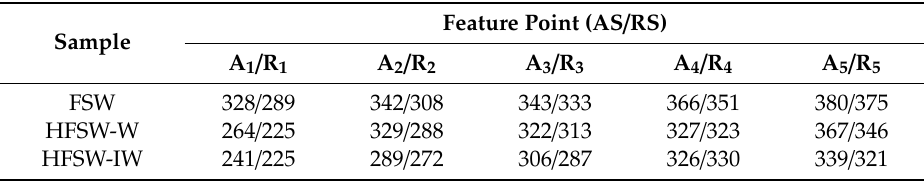
Figure 4. The heat cycling curves measured at: ( a ) the advancing side (A 1 to A 5 ) under the friction stir welding (FSW) condition; ( b ) the retreating side (R 1 to R 5 ) under the FSW condition; ( c ) the advancing side (A 1 to A 5 ) under the HFSW-W condition; ( d ) the retreating side (R 1 to R 5 ) under the HFSW condition; ( e ) the advancing side (A 1 to A 5 ) under the HFSW-IW condition; ( f ) the retreating side (R 1 to R 5 ) under the HFSW-IW condition. FSW means the conventional friction stir welding; HFSW-W indicates the heat pipe assisted friction stir welding with ambient temperature water as the cooling liquid; HFSW-IW is the heat pipe assisted friction stir welding employing ice water as the cooling liquid. Table 3. Peak temperature (°C) of each measuring points.